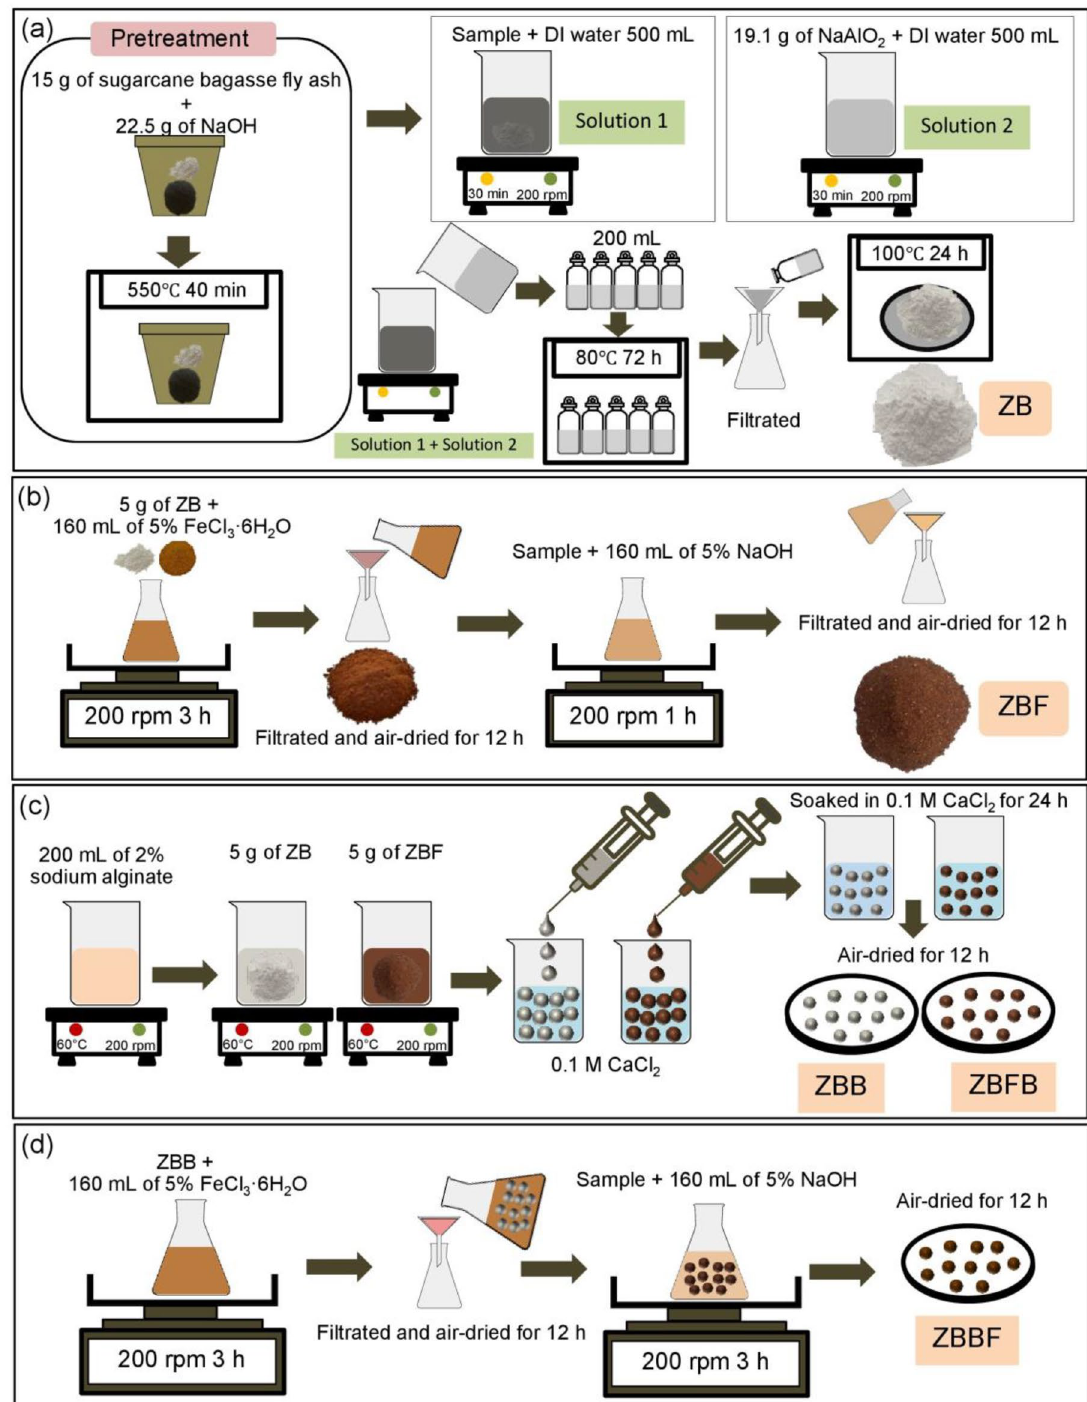
Figure 11. A flow diagram of the synthesis methods of ( a ) zeolite A sugarcane bagasse fly ash powder (ZB), ( b ) zeolite A sugarcane bagasse fly ash powder mixed iron(III) oxide-hydroxide (ZBF), ( c ) zeolite A sugarcane bagasse fly ash beads (ZBB) or zeolite A sugarcane bagasse fly ash powder mixed iron(III) oxide-hydroxide beads (ZBFB), and ( d ) zeolite A sugarcane bagasse fly ash beads coated iron(III) oxide-hydroxide